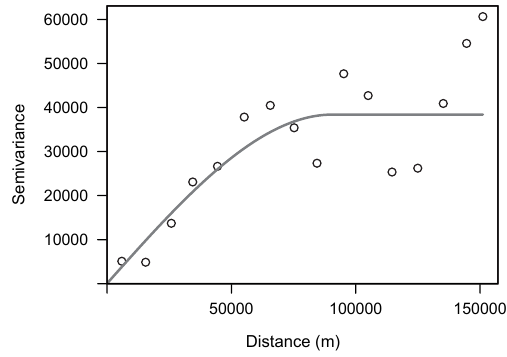
Figure 4. Empirical residual semivariogram of 2-week antecedent precipitation after accounting for elevation as well as a fitted spher- ical semivariogram